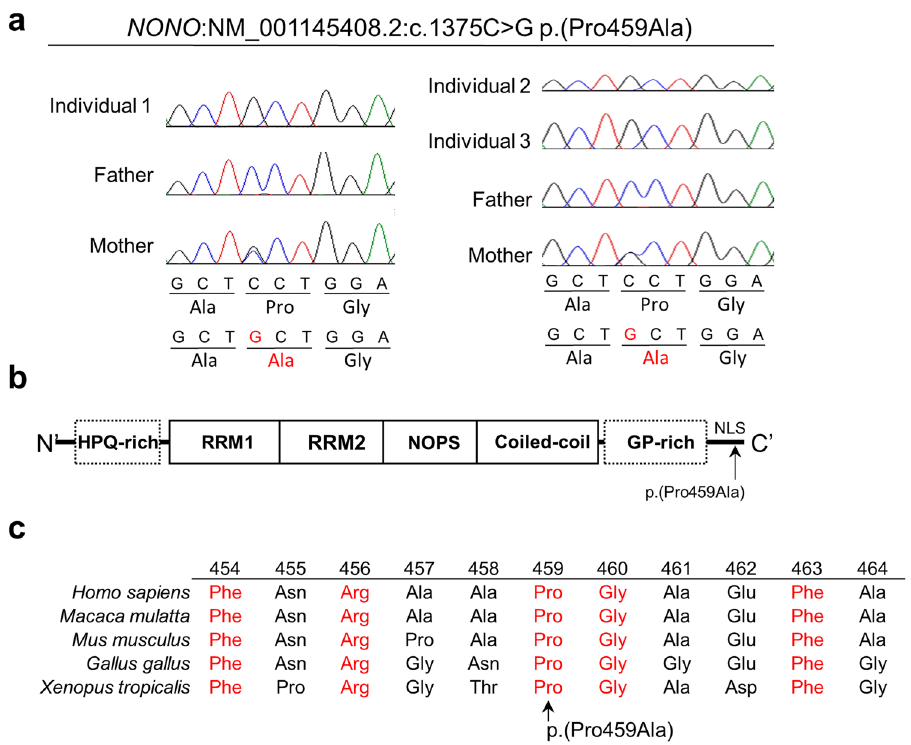
Figure 1. Genetic analysis of NONO variant. ( a ) Electropherograms show that Individuals 1–3 had a hemizygous NONO variant inherited from their mother. The altered nucleotide and amino acid are shown in red. ( b ) Schematic presentation of NONO domains (solid line) and regions (dashed line), and the identified variant (arrow). NLS, nuclear localization signal; NOPS, NonA/paraspeckle; RRM, RNA recognition motif. ( c ) Evolutionary conservation of NONO protein and its orthologs within vertebrates. Conserved amino acids are shown in